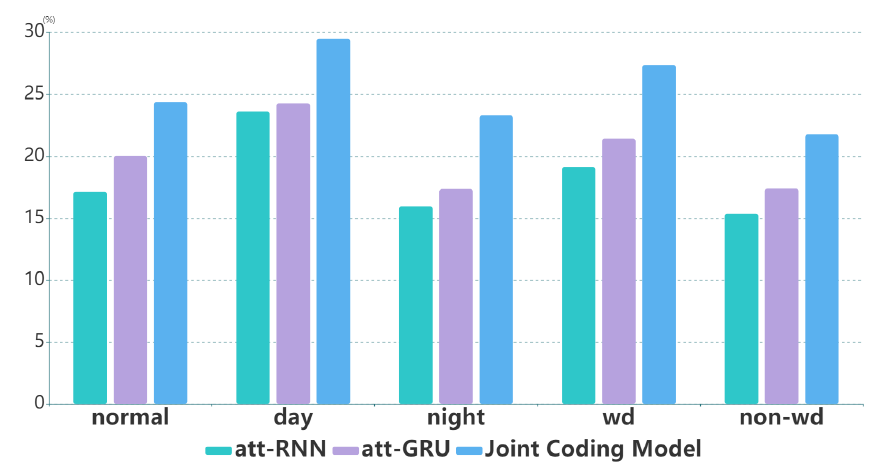
Figure 8. MRR@20 of different groups in experiment 2.